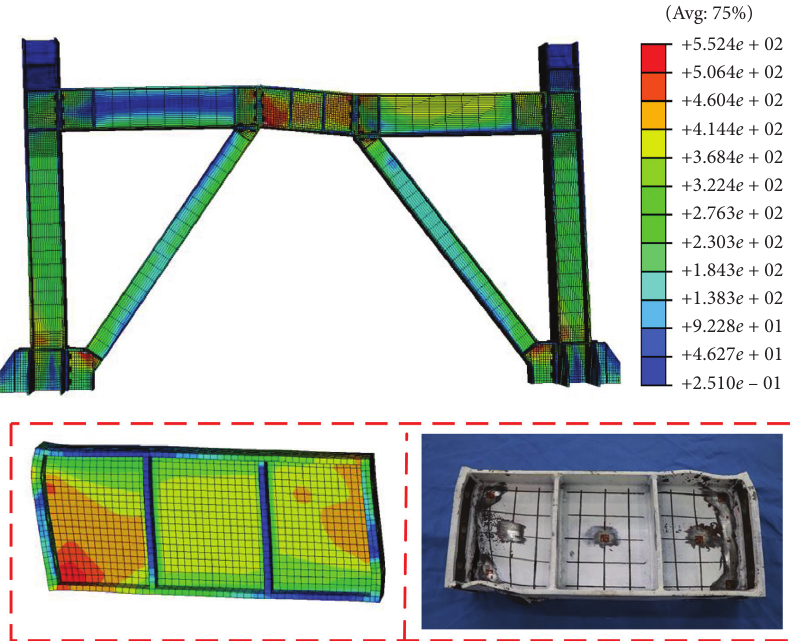
Figure 32: Comparison of failure modes and equivalent stress of PDKB-2 and KEBF-2.